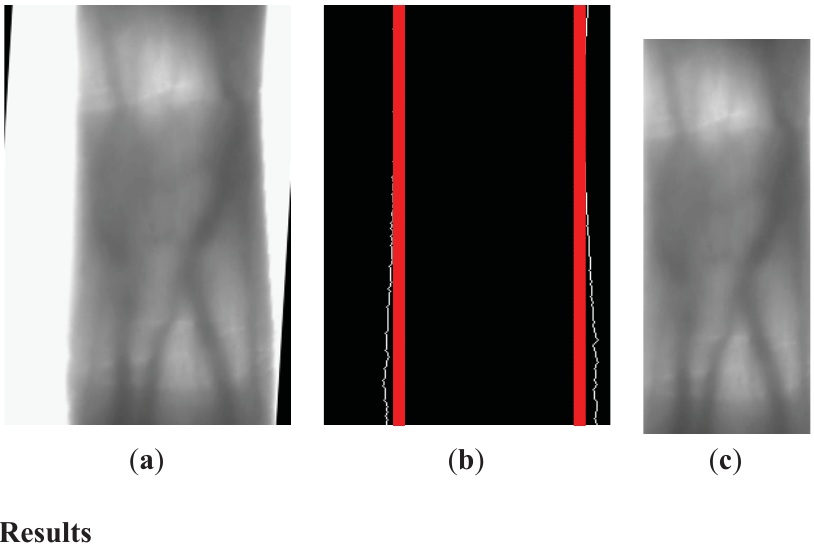
Figure 6. The width of the ROI. ( a ) The ROI with defined height. ( b ) The binary finger edge image with internal tangents. ( c ) The ROI of a finger vein image.